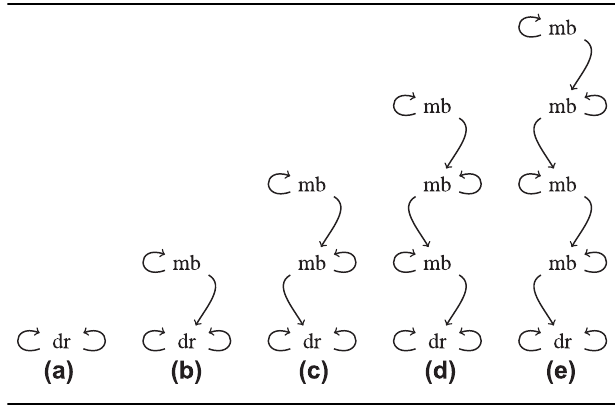
TABLE 1 | Different information states considered by Clark and Marshall (1981, C&M, pp. 11 – 14). Abbreviations: dr: A Day at the Races is showing, mb: Monkey Business is showing. Each node represents a possible world. Arrows w → v say that v is an epistemic possibility in world w ; arrows to the left point to possible worlds of the speaker ’ s information state ( ‘ Ann ’ ), arrows to the right to possible worlds of the hearer ’ s information state ( ‘ Bob ’ ). b) is Version 2 of C&M; c) is C&M ’ s Version 3; d) is their Version 4; and e) is their Version